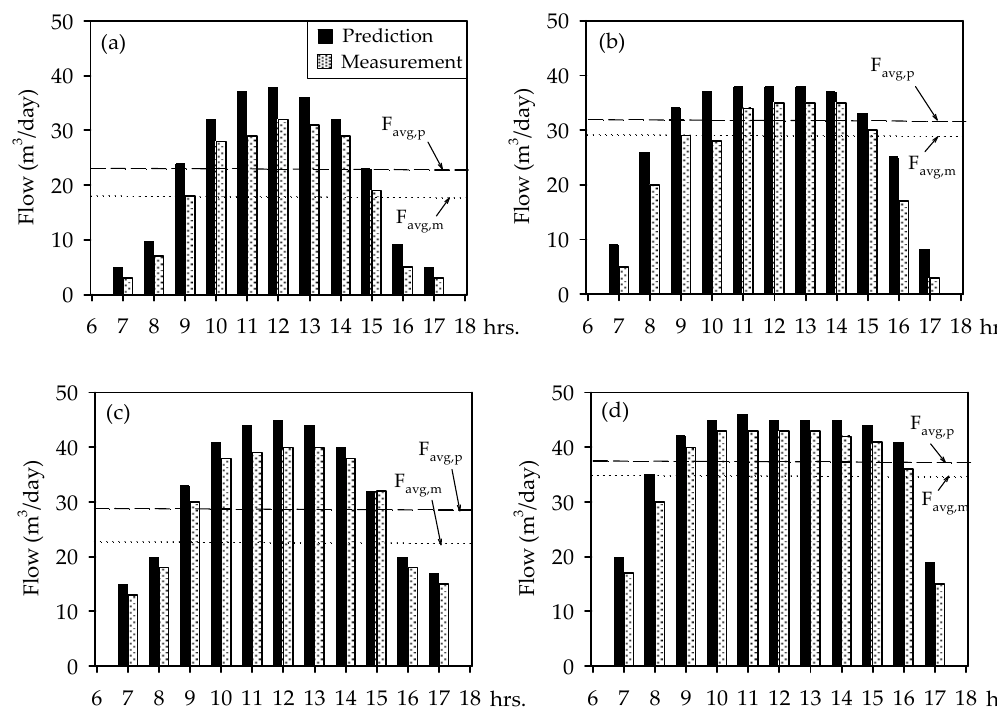
Figure 13. Daily predicted and measured water flow for Pongluek village without a tracker installed ( a ) and with a tracker ( b ) and Bangkloy village without a tracker installed ( c ) and with a tracker ( d ).